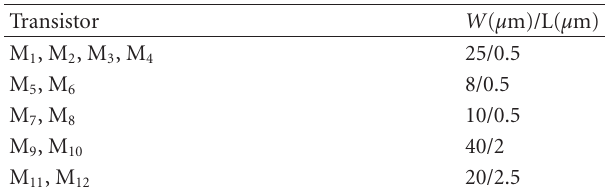
Table 2: Transistor aspect ratios of the ICCII+ are shown in Figure